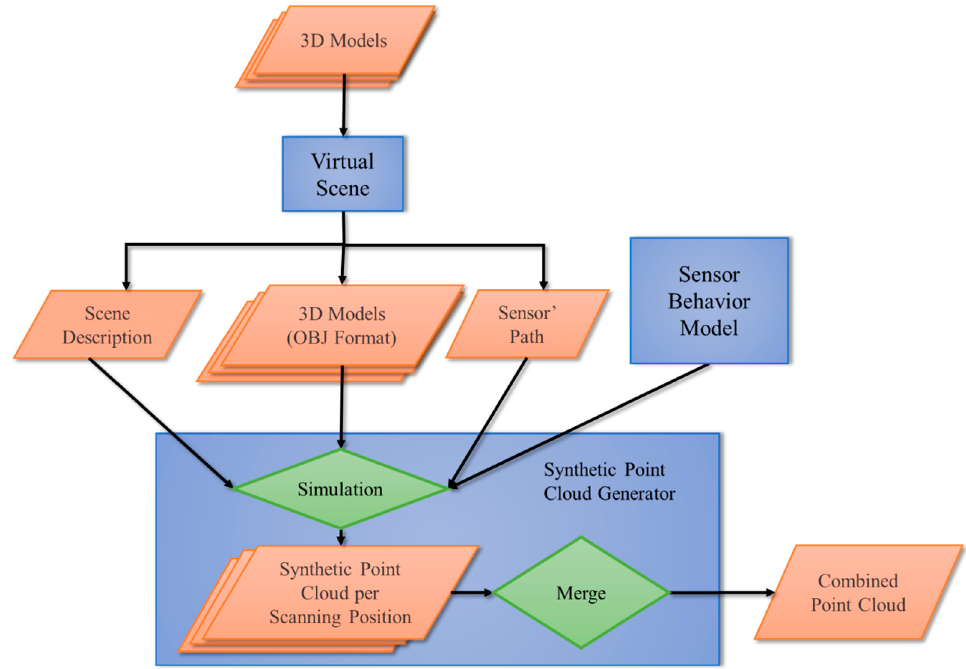
Figure 3. optScan structure flowchart: Parallelograms are inputs, rectangles are modules, and diamonds are internal applications essential for generating Synthetic Point Clouds.